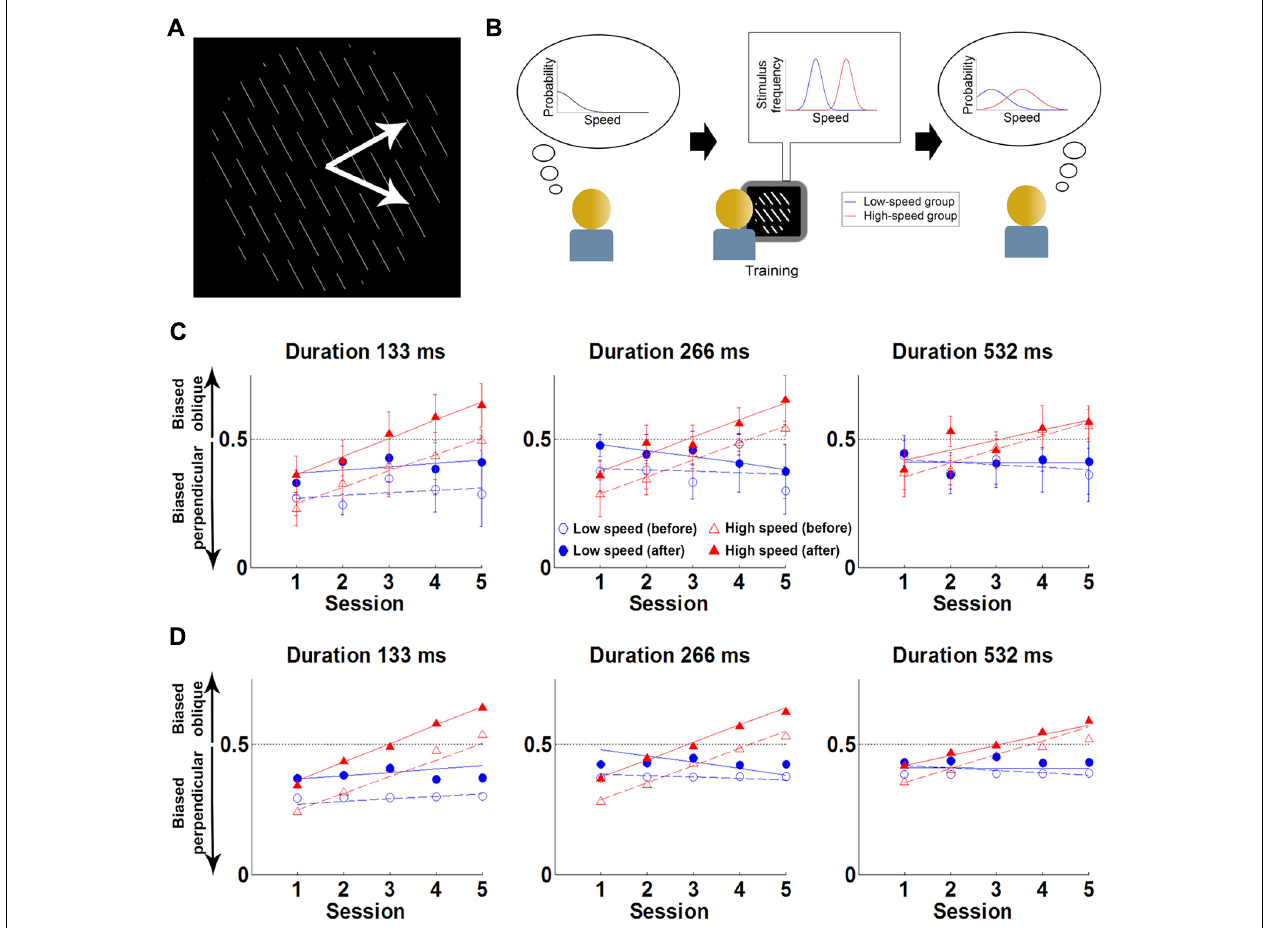
FIGURE 3 | Experiment and main results of Sotiropoulos etal. (2011a). (A) The stimulus is a field of lines translating rigidly along either of the two directions shown by the white arrows (the latter are not part of the stimulus). The task of the participants is to report the direction of motion (“up” or “down”), without feedback. (B) Cartoon of experimental hypothesis. Left: initially participants have a prior favoring slow speeds. Middle: the low-speed group was exposed to low speeds (blue), while the high-speed group viewed faster speeds (red). Right: training will lead the high-speed group to shift their prior expectations toward higher speeds (red) compared to the low-speed group (blue). (C) Results: Proportion of oblique perceptions ( p o ) in low-contrast condition, for three trial durations. Each point is the p o for the first (empty symbols) or last (filled symbols) test block of the